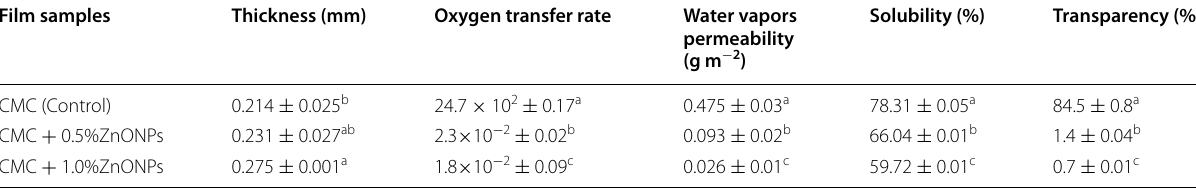
Calculated mean is for triplicate measurements from three independent experiments a–c Means with different superscripts in the same column are considered statistically different (LSD test, P